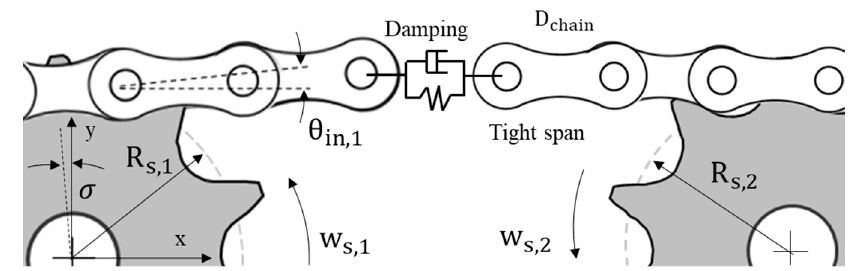
Figure 5. Schematic of damping force between two sprockets.